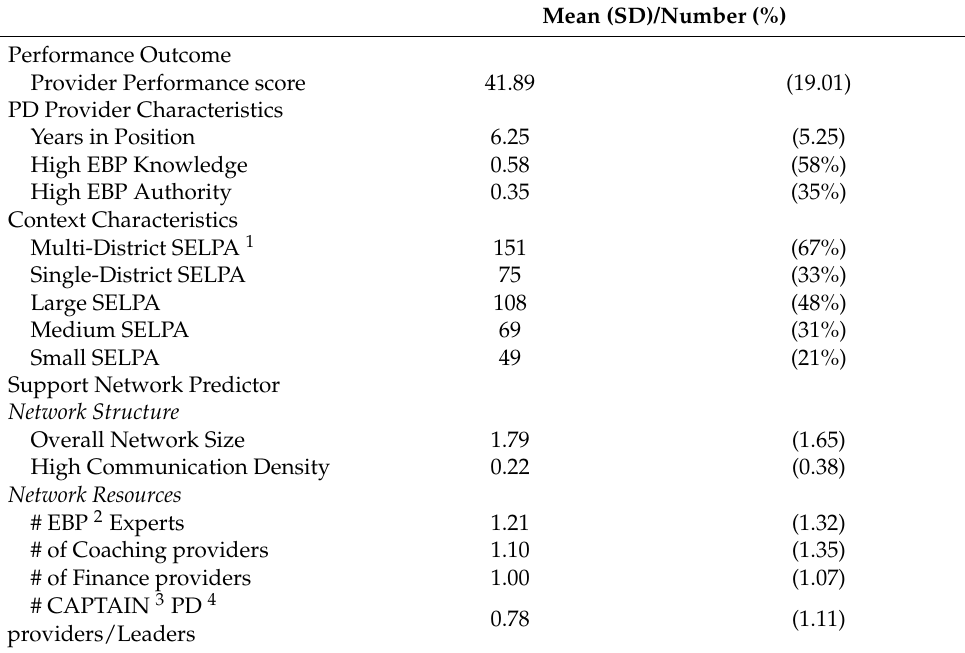
Table 1. Variable descriptive